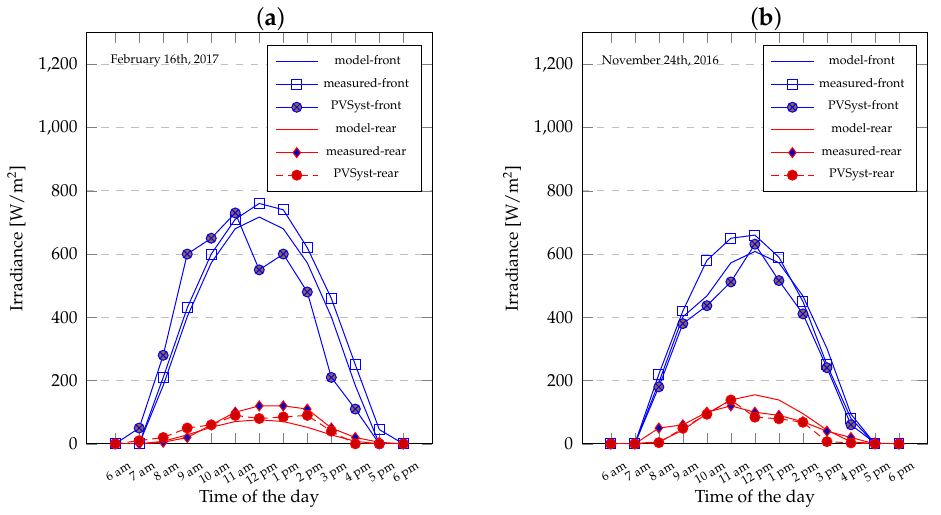
Figure 15. Estimated model, PVSyst 6.7.6 and measured value comparison for the front and rear sides for two specific days ( a ) 16 February 2017, ( b ) 24 November